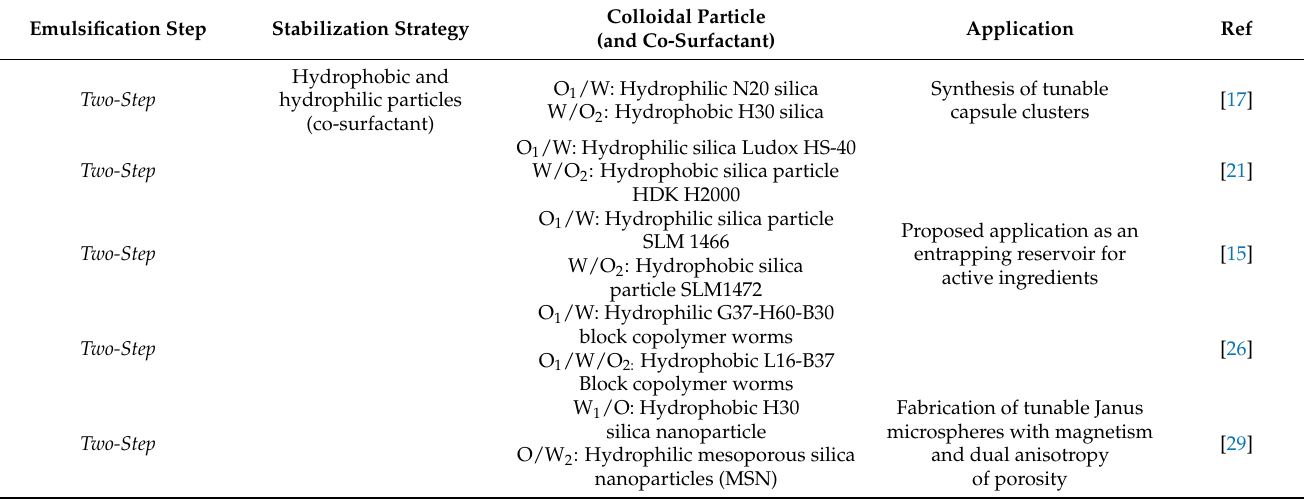
Table 1. Summary of Stabilizing Strategy, colloidal particles, and applications of